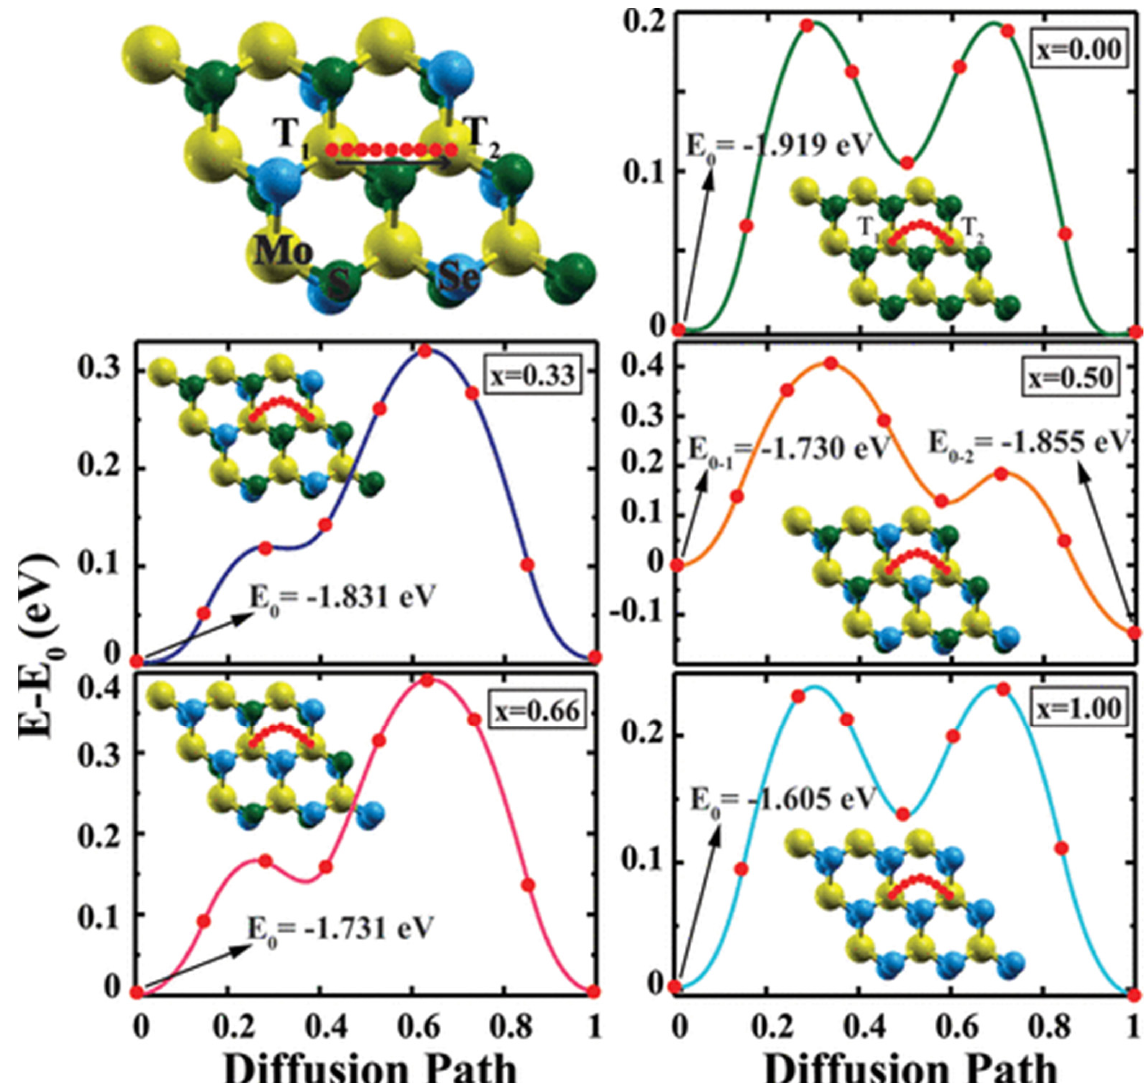
Figure 9. Lowest energy diffusion paths of a single lithium atom and calculated energy profiles along the paths for one Li atom adsorbed on the TMDs monolayer. Reproduced with permission of ref. [174]. Copyright 2015. American Chemical Society.